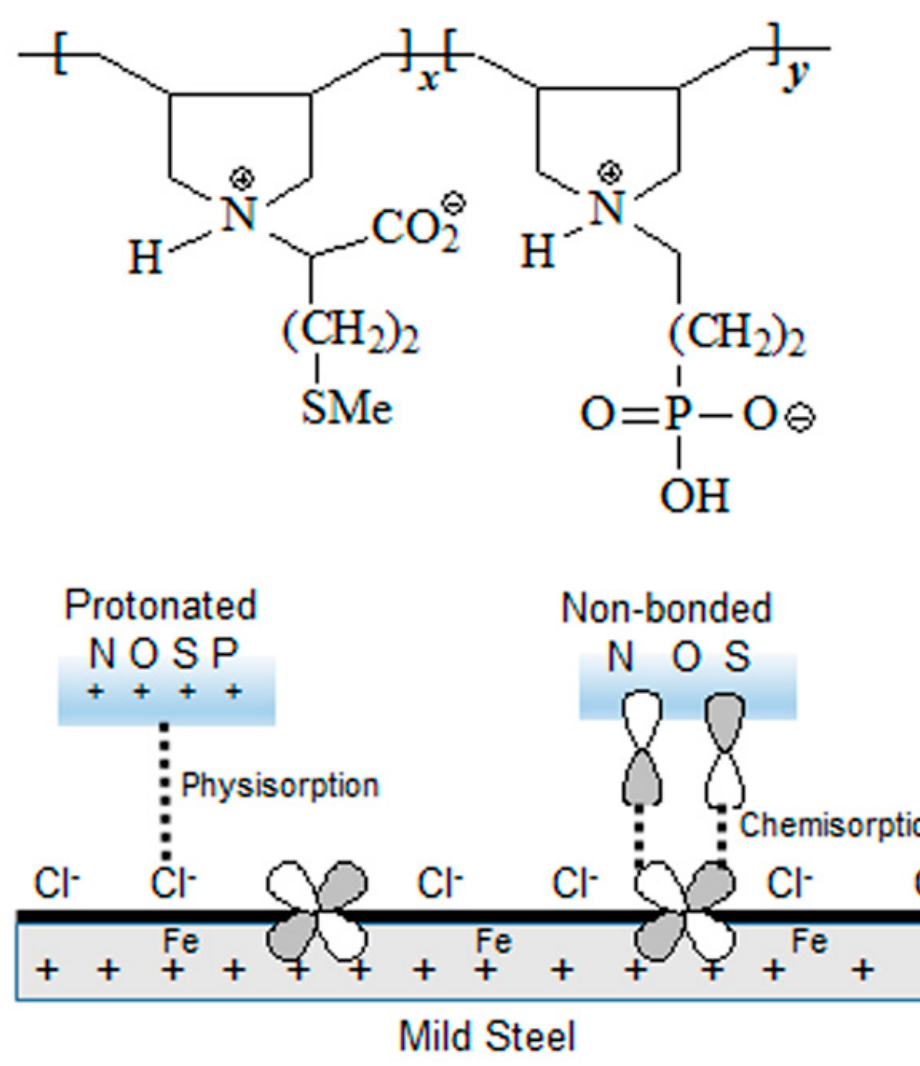
Figure 12. The schematic adsorption mechanism of corrosion inhibitors.